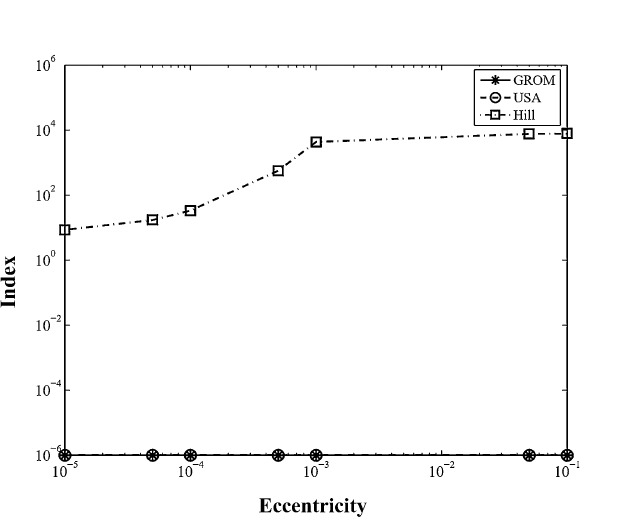
Figure 7. Index Comparison for various eccentricities.